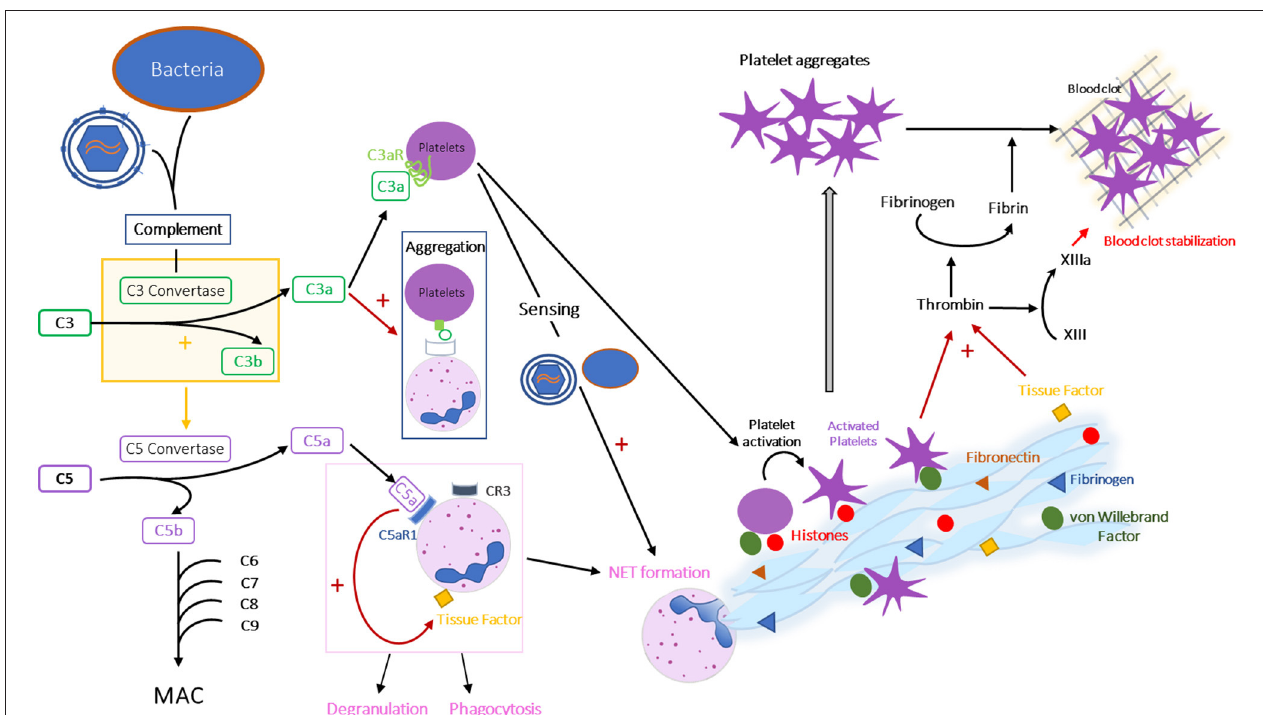
FIGURE 5 | Interplay between complement, coagulation and formation of NETs. Schematic representation of the interactions between complement, coagulation and formation of NETs during HIV/SIV infection. CR, complement receptor; C3aR, C3a receptor; C5aR1, C5a receptor 1 or